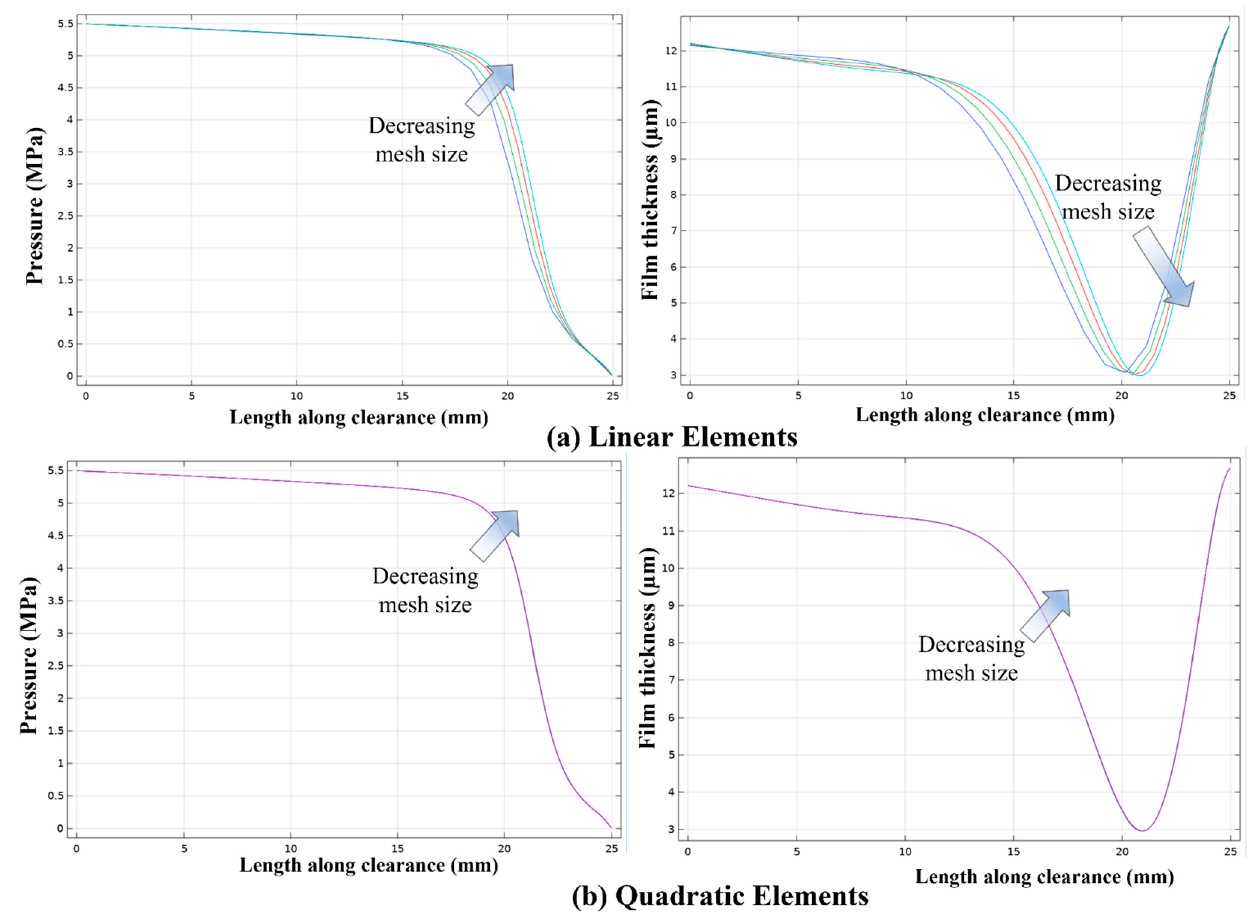
Figure 9. Mesh independency study using linear and quadratic shape functions for FEM discretization, and using 1, 0.9, 0.8, and 0.7 mm mesh sizes at a film thickness of 0.0127 mm and an inlet pressure condition of 5.5 MPa. The solution changes with decreasing mesh size with a linear shape function, while the results with the quadratic element show that the solution is mesh-independent.